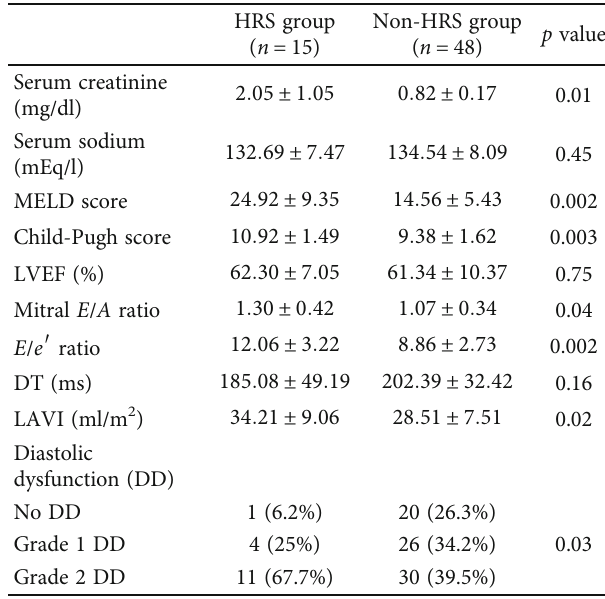
Table 4: Baseline characteristics of cirrhotic patients with moderate ascites who developed HRS and those who did not develop HRS during follow-up.